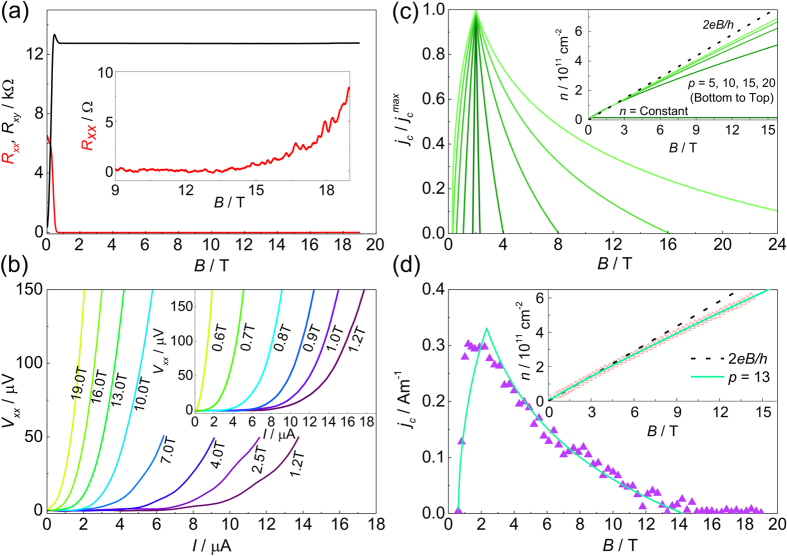
Quantum Hall effect in ultra-low carrier density epitaxial graphene.(a) Continuous field measurements of the quantum Hall effect at 2 K using a constant measurement current of 1 μA in an epitaxial graphene on SiC sample with the zero field carrier density reduced to 1.5 × 1010 cm2 by corona discharge at room temperature. Inset: an expanded plot of Rxx towards the end of the plateau. (b) I − Vxx traces indicating the onset of the quantum Hall breakdown for the high magnetic field side of the plateau and inset, for the low field side. (c) Theoretical dependence of the breakdown current for the ν = 2 quantum Hall plateau using equations (1) and (6) with B0 = 0.3 T and Bc = 2.0 T. A set of dependences are shown with the power, p, chosen as 5, 10, 15, and 20. The traditional triangular dependence of breakdown current on magnetic field for constant n becomes stretched and asymmetric as the carrier density tends towards an almost linear dependence on magnetic field. The inset shows the corresponding field dependent carrier densities. (d) Magnetic field dependence of the breakdown current (purple triangles) for the ν = 2 plateau and a best fit (solid line) using equations (1) and (6) with the power p = 13. The inset shows the corresponding magnetic field dependent carrier density.